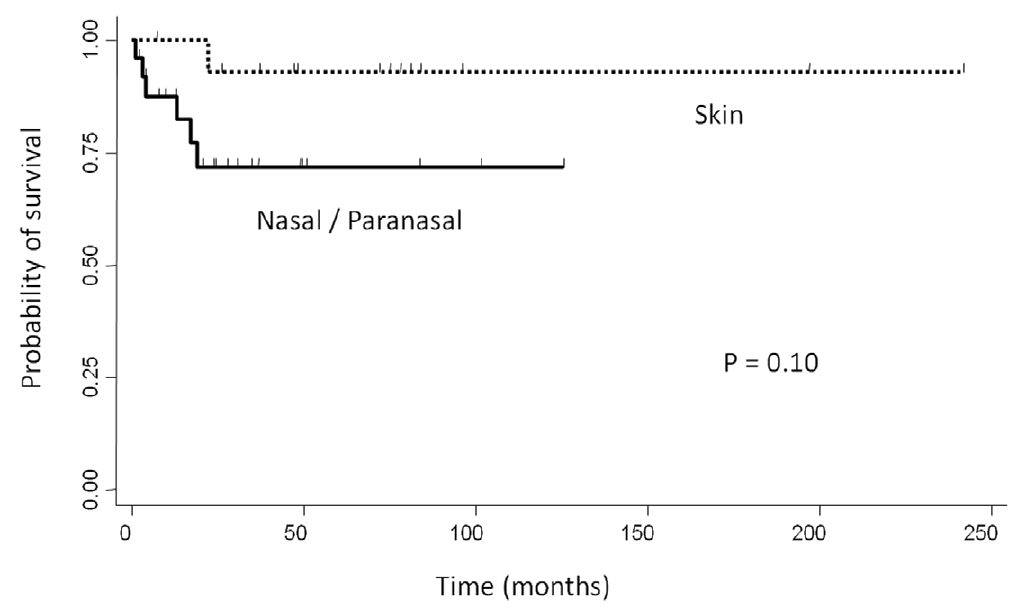
Figure 5. Comparison of overall survival between localized nasal/paranasal DLBCL and localized skin DLBCL.